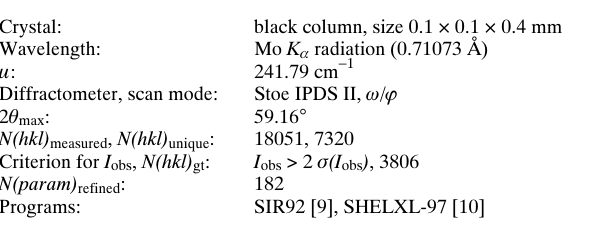
Table 1. Data collection and